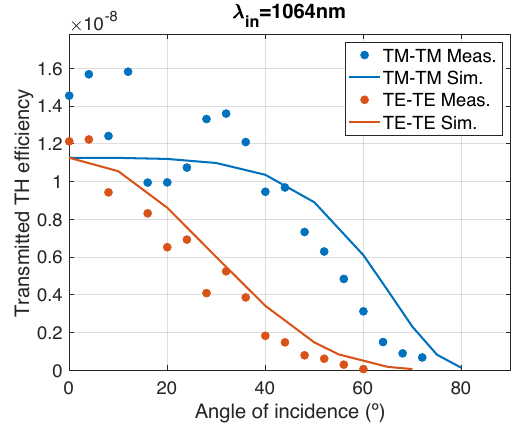
Fig. 4. Measured (full circles) and predicted (solid curves) transmitted THG efficiencies as a function of the angle of incidence from the 20nm-thick Au layer when the incident field is tuned at 1064nm. A TM- (blue) and TE-polarized (red) TH field is detected when the fundamental field is TM- or TE- polarized, respectively.